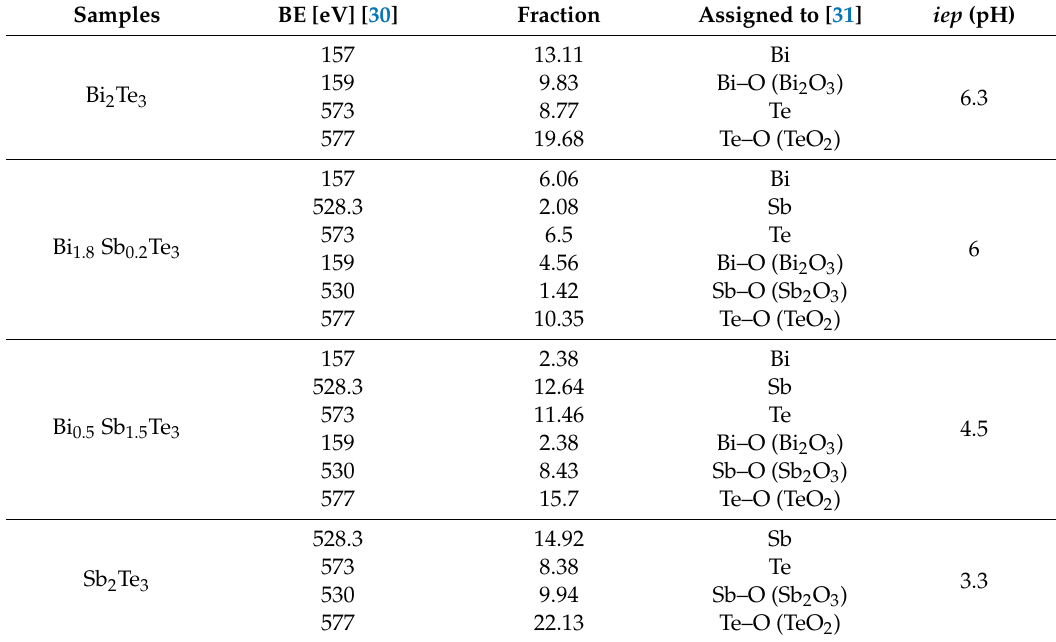
Table 1. XPS peak fitting results for Bi 4f, Sb 3d, and Te 3d regions for bulk samples, and the measured iep values for the Bi 2 − x Sb x Te 3